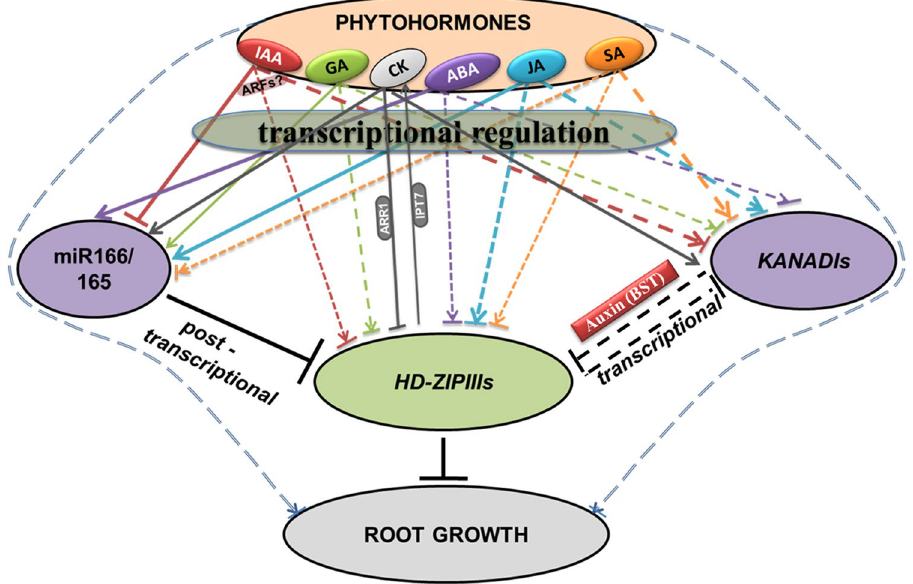
Figure 7. A hypothetical model showing complex crosstalk among phytohormones, miR166/165, HD-ZIP IIIs and KAN genes regulating root growth. miR166/165 and HD-ZIP IIIs mediated root growth and development is regulated by various hormones such as IAA (red lines), GA (green lines), CK (grey lines), ABA (purple lines), JA (blue lines) and SA (orange lines) through transcriptional regulation of miR166/165, HD-ZIP IIIs and KAN genes. CK mediated regulation was adapted from 34 . miR166/165 post transcriptionally regulates HD-ZIP IIIs expression, whereas KANs and HD-ZIP IIIs regulate each other transcriptionally through auxin biogenesis, signaling, transport components 36, 37 . Solid thick lined arrows indicate strong transcriptional induction of genes. Solid thick lines with stop bars indicate strong transcriptional repression of genes. Narrower lined arrows/stop bars represent moderate or weak induction/repression, respectively. Dotted lines with arrow and repression mark represent both induction and repression of expression. Two dotted double lines (blue) with arrow/stop bars indicate hormonal regulation of root growth independent of miR166/165 and HD-ZIP IIIs